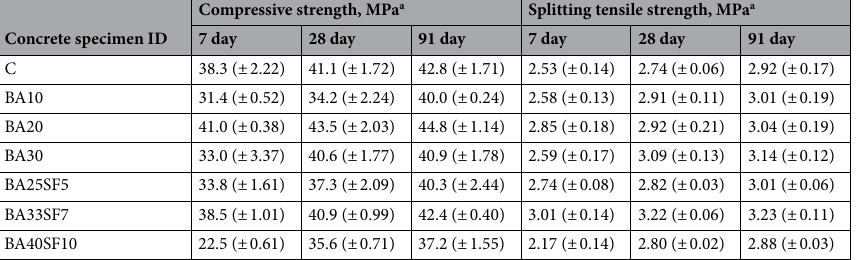
Table 4. Compressive and tensile strengths of concrete with respect to aging. a Values in parenthesis indicate the standard deviation of all test results.